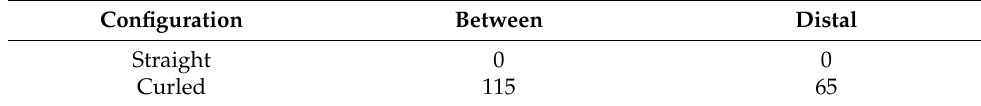
Table 1. Values obtained from the configuration of Figure 2. Configuration Between